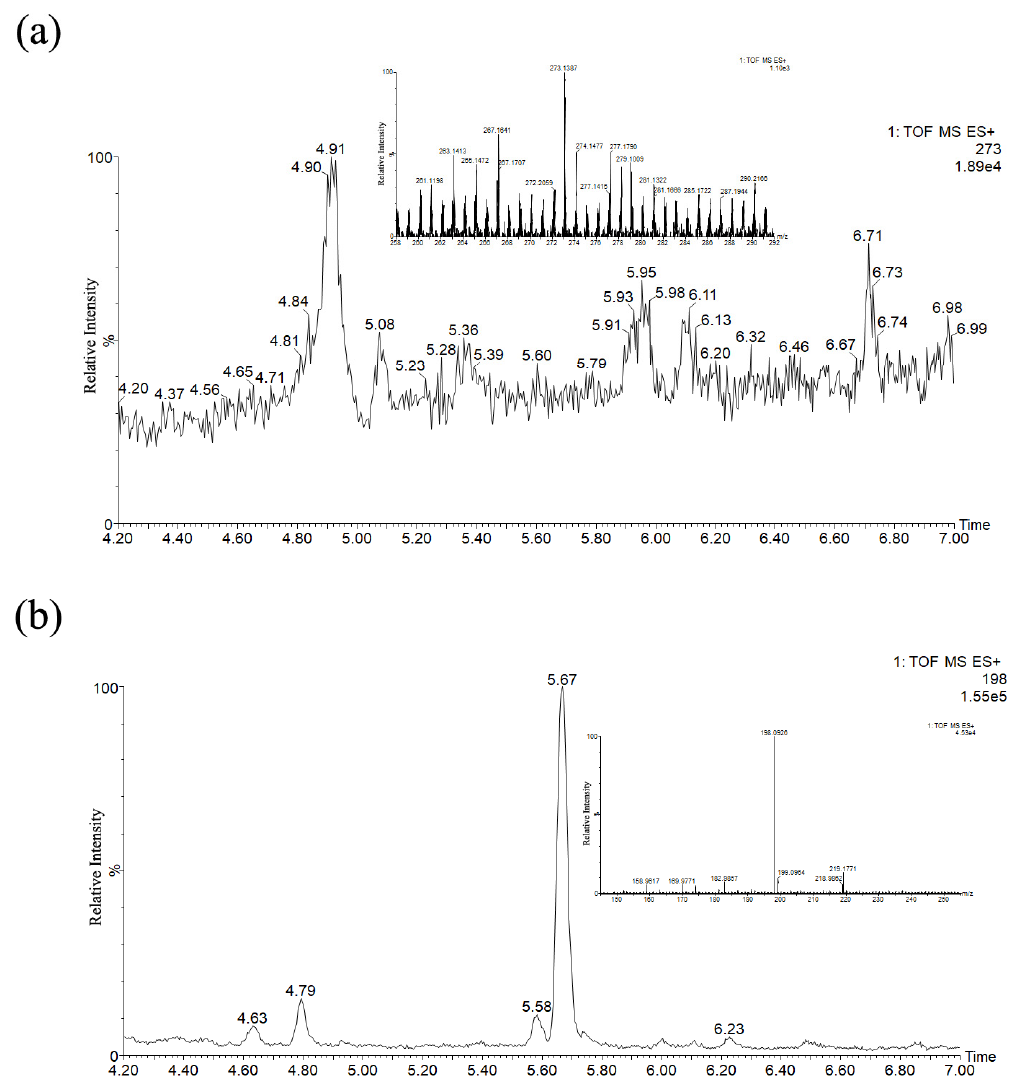
Figure 9. EIC intensities comparison of the first ( a ) and second ( b ) pathways of the final products in the faded